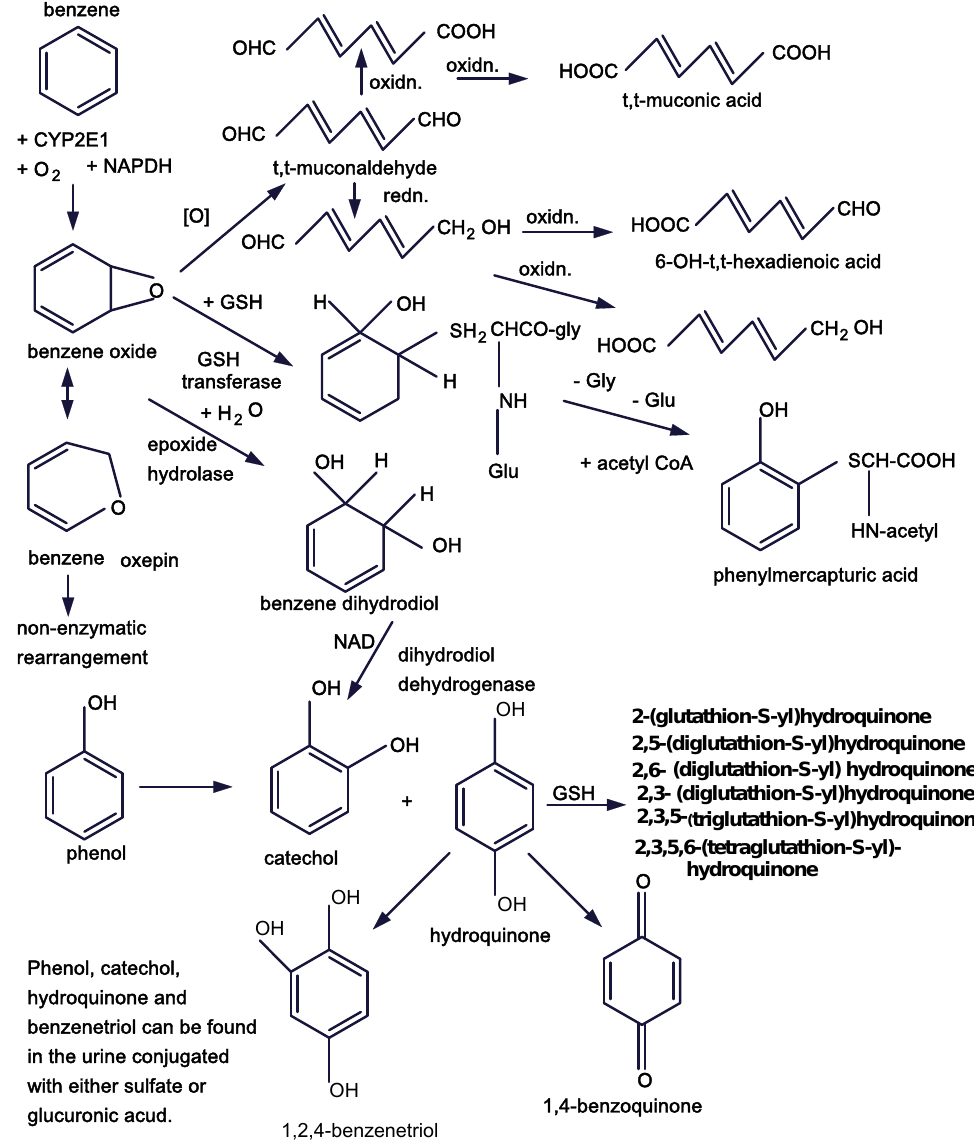
Figure 1. Benzene metabolic